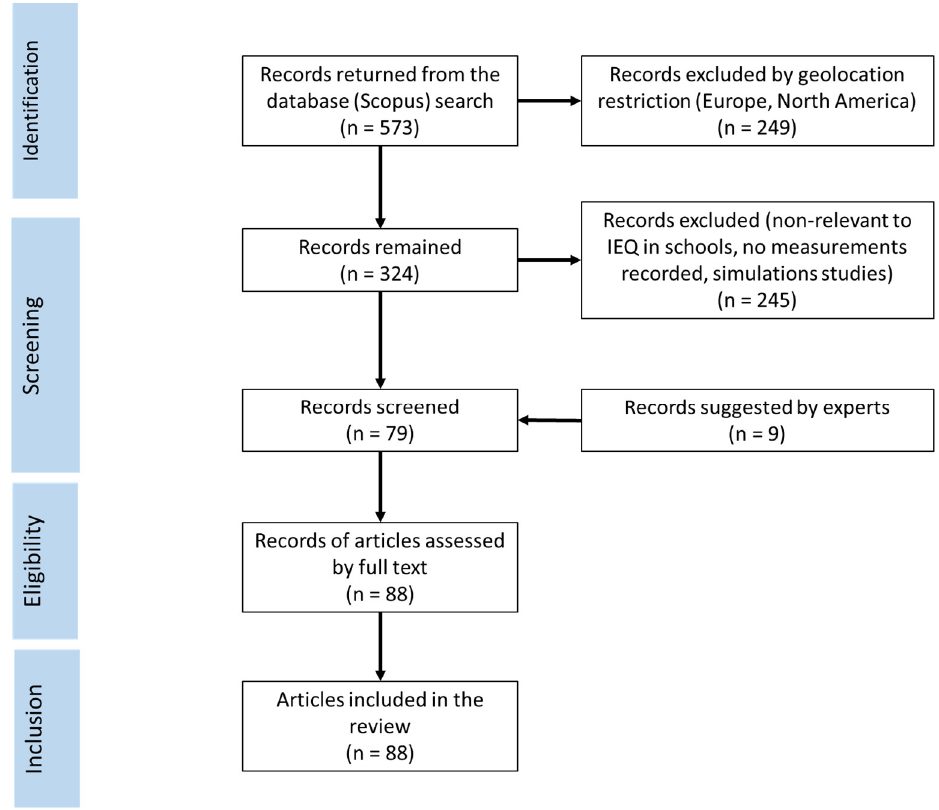
Figure 1. Review flowchart.